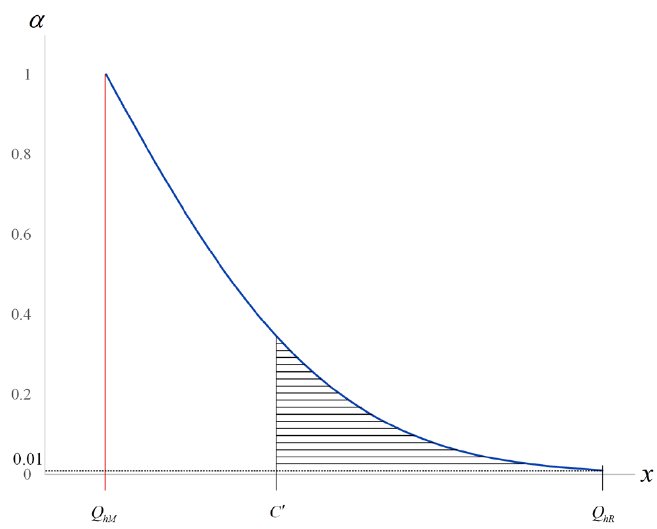
= x η with vertical line x C ′ . h